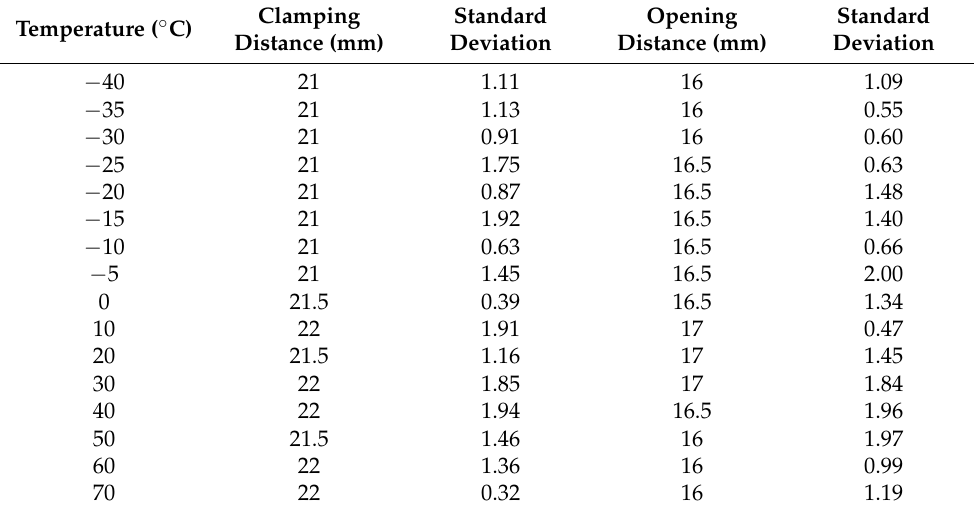
Table 4. USP 131 magnetic contact on and off values during experimental